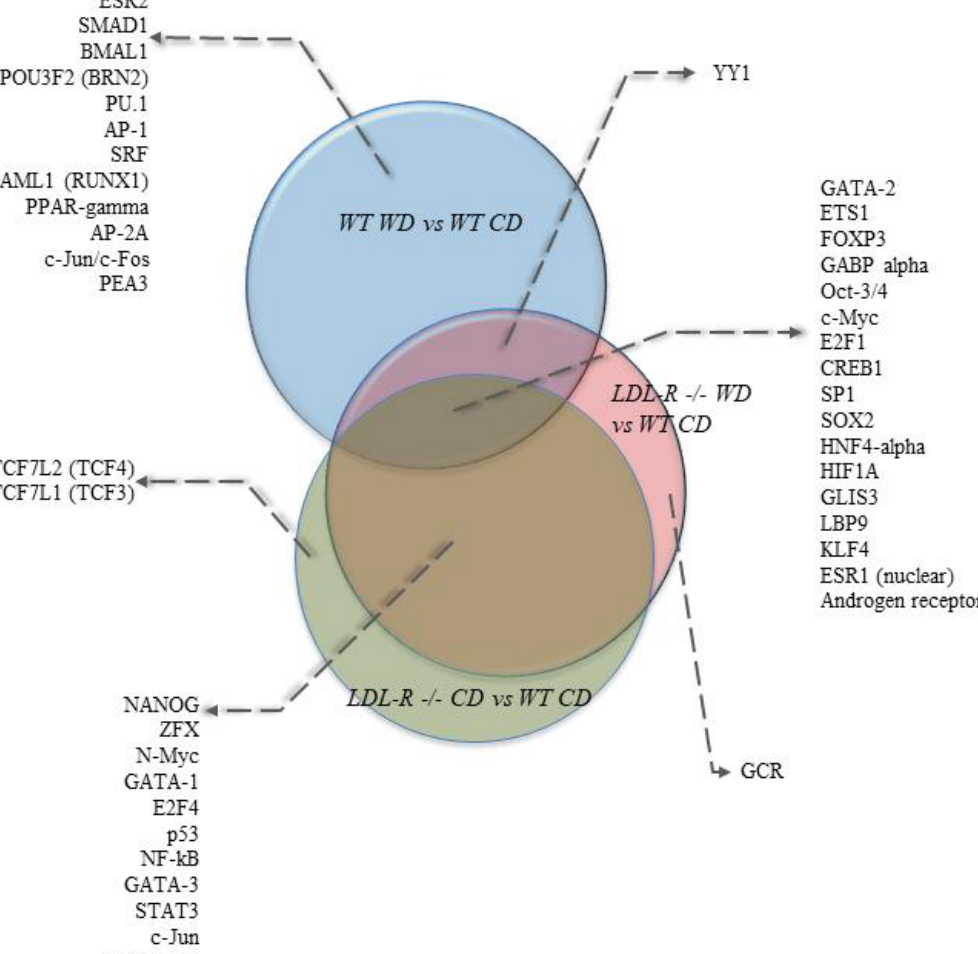
Figure 4. Venn diagram of the top 30 transcription factors affected by diet and genotype in hippocampal microvascular endothelium. Transcription factors potentially modulated by lipid injury were identified using a MetaCore transcription regulation algorithm. Venn diagram shows 17 transcription factors (TFs) in common for the Western diet (WD)-fed C57BL/6J (WT) mice, control diet (CD)-fed LDL-R−/− mice, and WD-fed LDL-R−/− mice, when compared with the CD-fed WT mice.